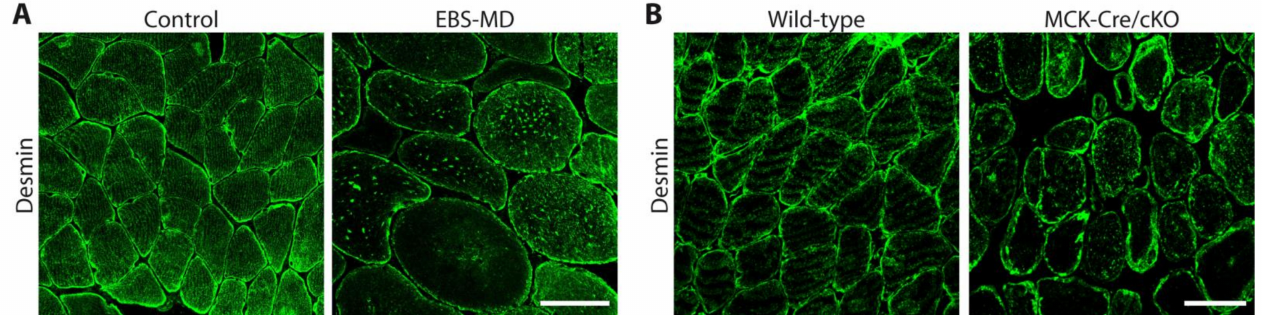
Figure 3. Immunofluorescence microscopy of longitudinal cryosections from healthy control and EBS-MD skeletal muscle specimens using antibodies to plectin (red labelling) and desmin (in green). Note the striated pattern and co-localization of plectin and desmin in the control muscle as well as the absence of plectin staining and the massive aggregation of desmin intermediate filaments (IFs) in the EBS-MD muscle. Scale bars: 20 µ m. (Image of EBS-MD patient, courtesy of R. Schröder).